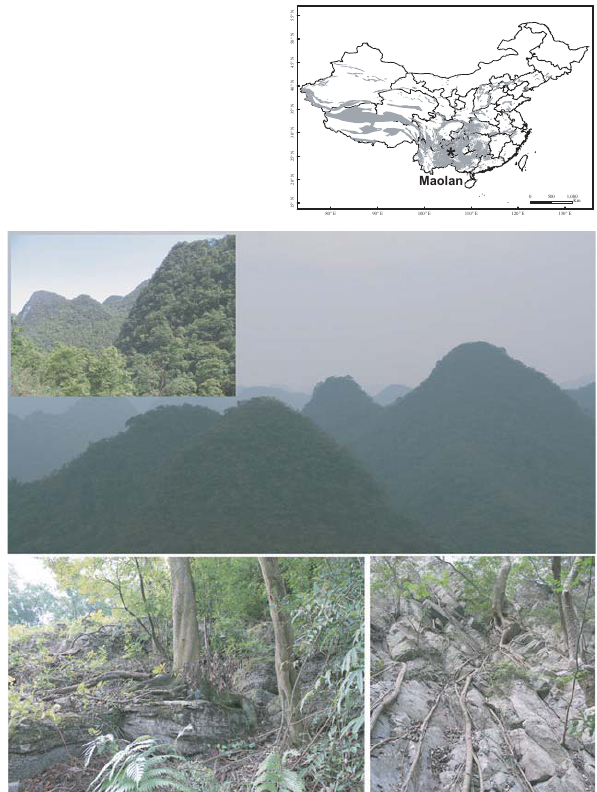
Figure 1. Location of study area in the distribution map of karst terrain in China, and the less-human-disturbed karst peak-clump depression landscape and well-protected mixed evergreen and de- ciduous broad-leaved forest with roots distributed in rock outcrops in Maolan National Natural Reserve, southern Guizhou